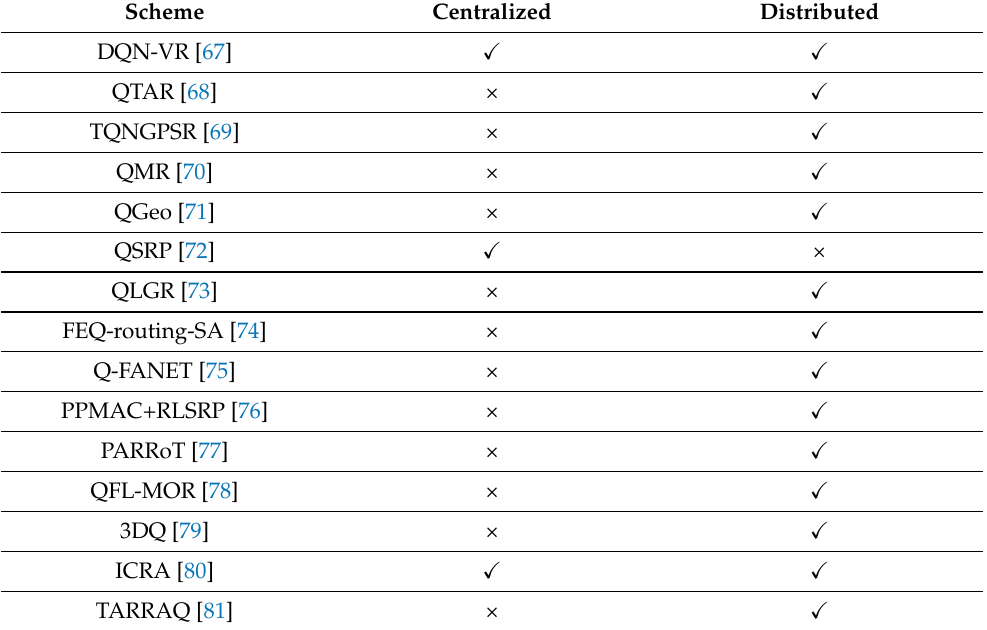
Table 31. Comparison of RL-based routing methods based on the routing process.